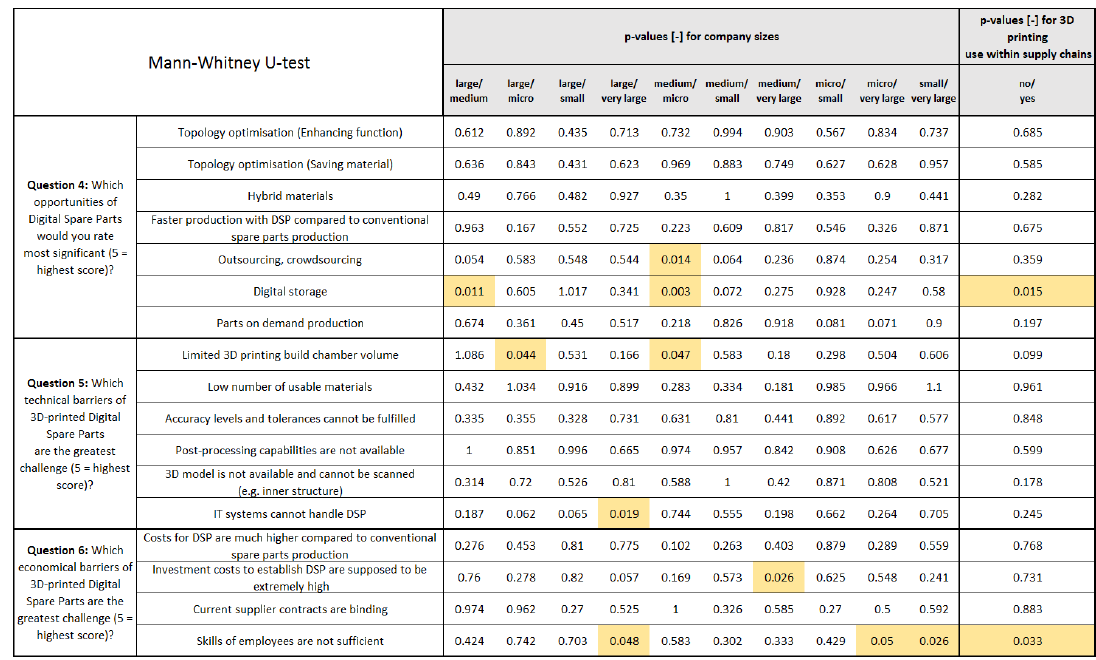
Figure A1. Mann-Whitney U-test: The influence of the company size and the effect of 3D printing usage within supply chains. A p -value of less than 0.05 indicates significance (highlighted values).